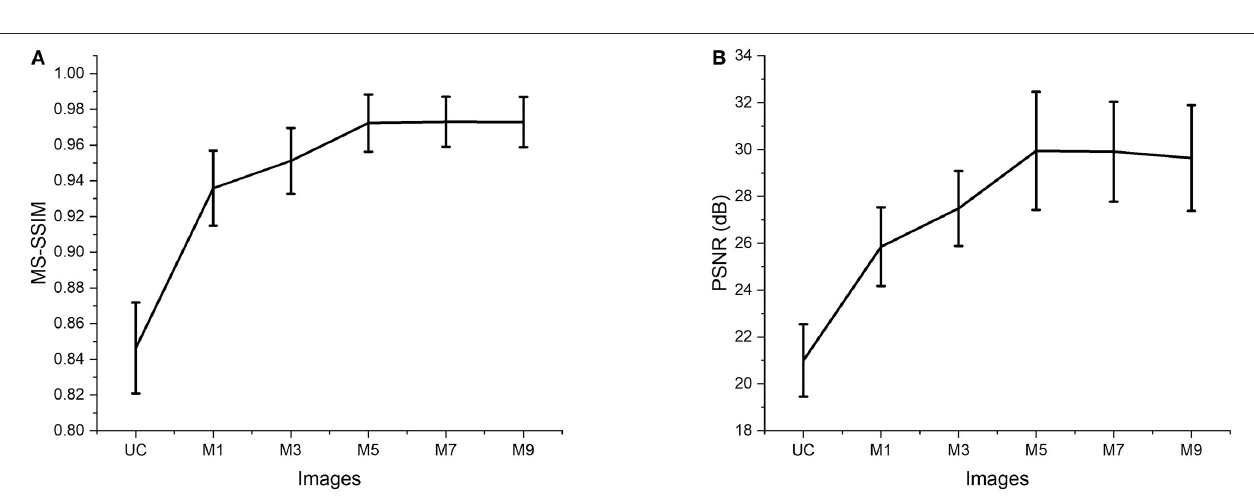
FIGURE 4 | Quantitative evaluation of MS-SSIM (A) and PSNR (B) . Average values are used for the graphical representation. UC represents the uncompensated images; M1, M3, M5, M7, and M9 represent the images acquired from ADC-Net with the single, three, five, seven, and nine input channel